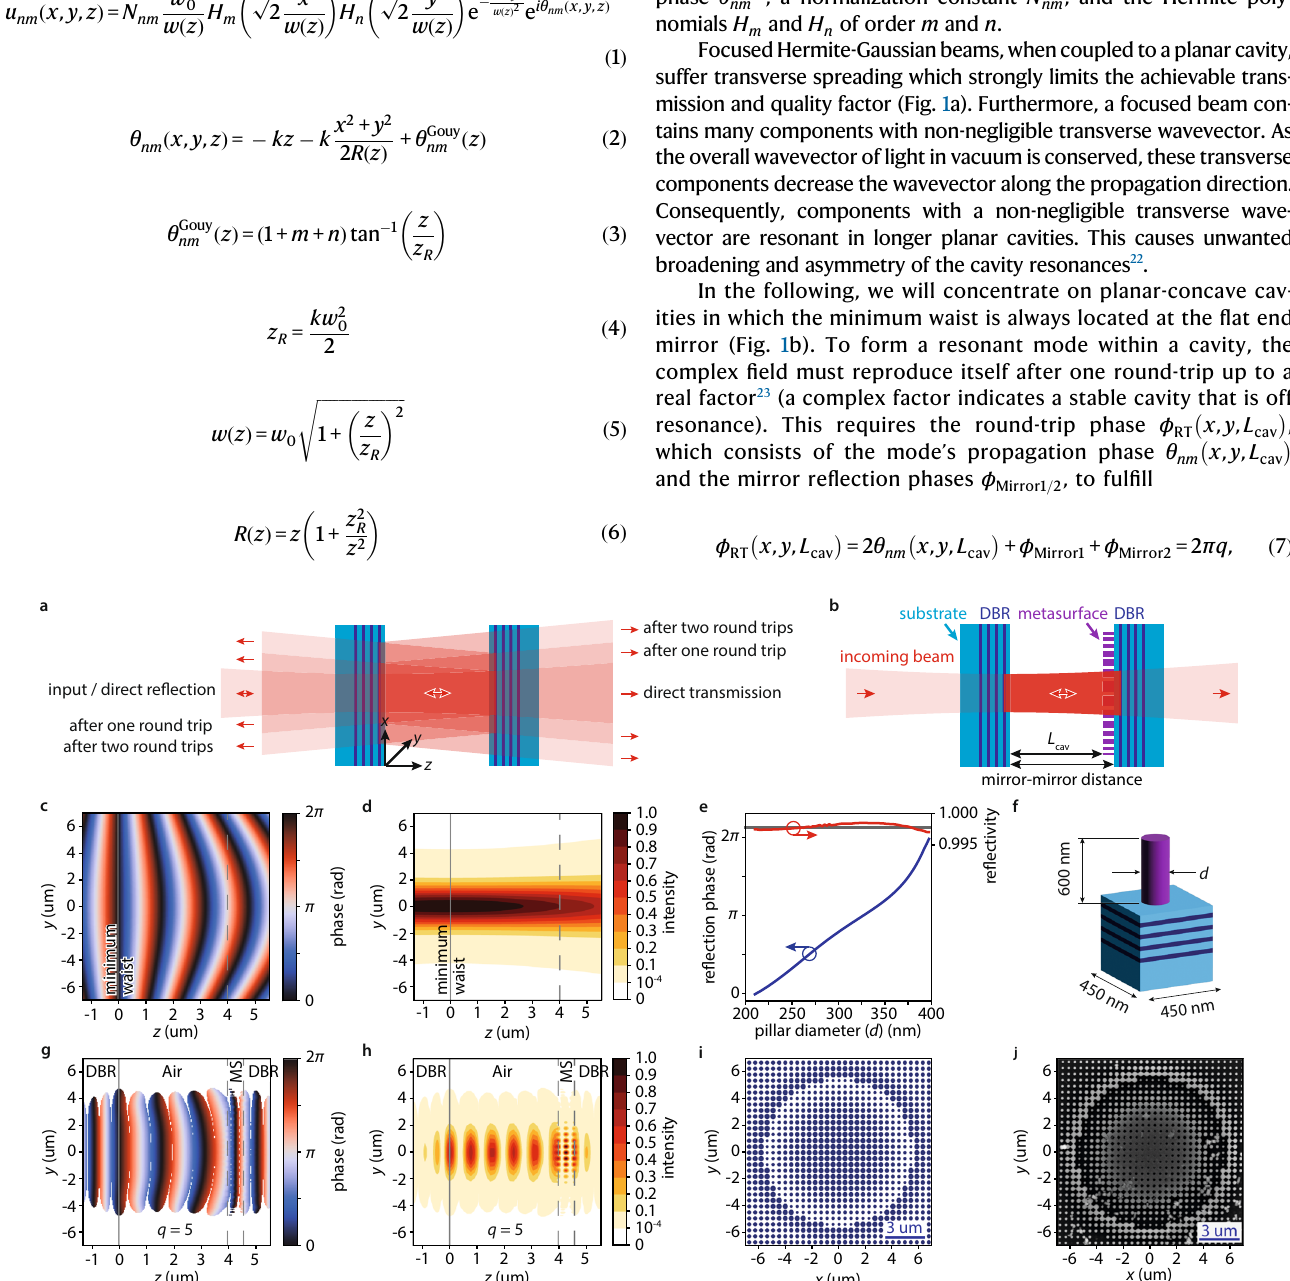
Fig. 1 | Concept of a metasurface-stabilized optical microcavity. a a focused Gaussianbeamoflight(red)coupledfromtheleftintoanopticalFabry-Perotcavity consisting of two opposing planar distributed Bragg re fl ectors (DBRs, light blue: Silica, dark blue: Titania) is only con fi ned along the propagation direction ( z ). Transverse spreading of the beam limits fi eld build-up in the cavity and transmis- sion through it. b a metasurface (violet) placed on the surface of the second DBR matchesthephaseevolutionofthefocusedGaussianbeamthuscon fi ninglightalso inthetransversedirections( x , y ).Thefreespacecavitylength L cav isreducedbythe heightofthemetaatoms. c phaseevolution(false-colorplot)ofaHermite-Gaussian beam (transverse mode indices n , m =0). Its minimum beam waist w 0 =1 : 9 um is located at position z =0 um along the propagation direction and transverse posi- tion y =0 um. We design the metasurface phase to match the wavefront at z =4 : 0 um (dashed grey line), which is equivalent to a metasurface effective radius of